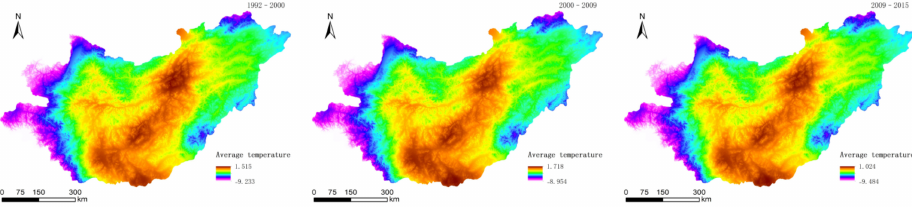
Figure 8. Average temperatures in 1992–2000, 2000–2009, and 2009–2015. According to the official statistics of NASA, raster data of the world population in 1990, 2000, 2010, and 2015 were obtained, and raster layers of population density changes in the basin in 1992–2000, 2000–2009, and 2009–2015 were obtained (Figure 9).